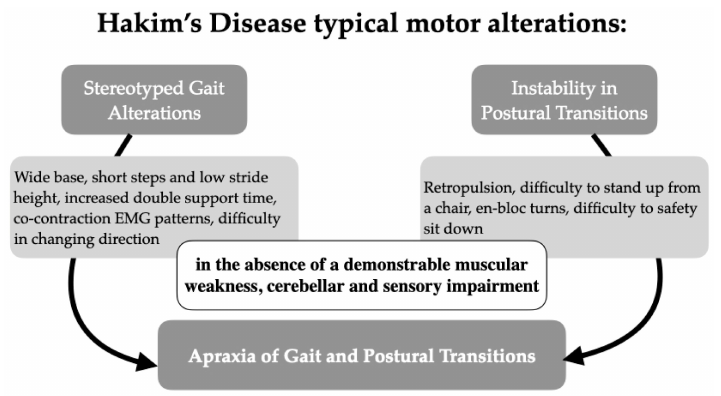
Figure 3. Proposal for a definition of motor abnormalities in idiopathic normal pressure